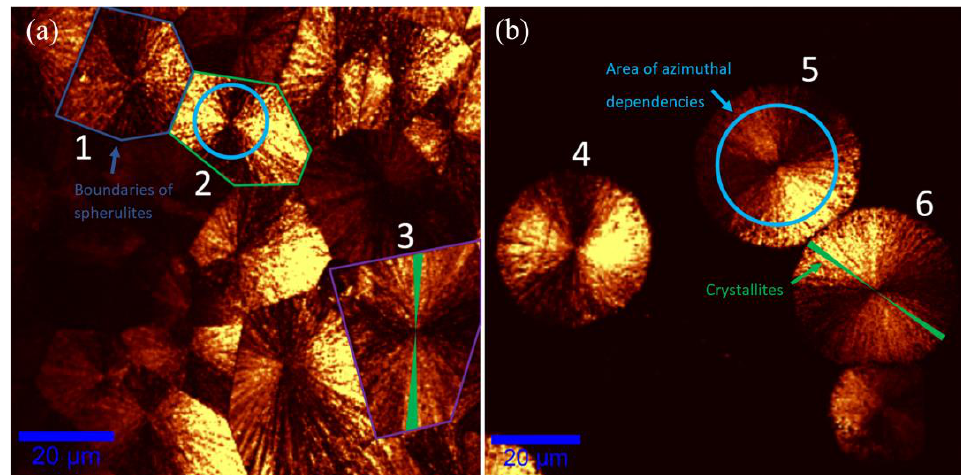
Figure 3. Surface image (SHG) for samples on silicon with joint spherulites PZT/Si 580 ( a ) and with separate spherulites PZT/Si 550 ( b ). The colored polygons on left image show boundaries between spherulites. Examples of circles where the local areas under study were located are shown on spherulites with numbers 2 and 5 (on other spherulites they are the same). Supposed shape of crystallites that grew to either side of the center is shown on spherulites numbered 3 and 6.